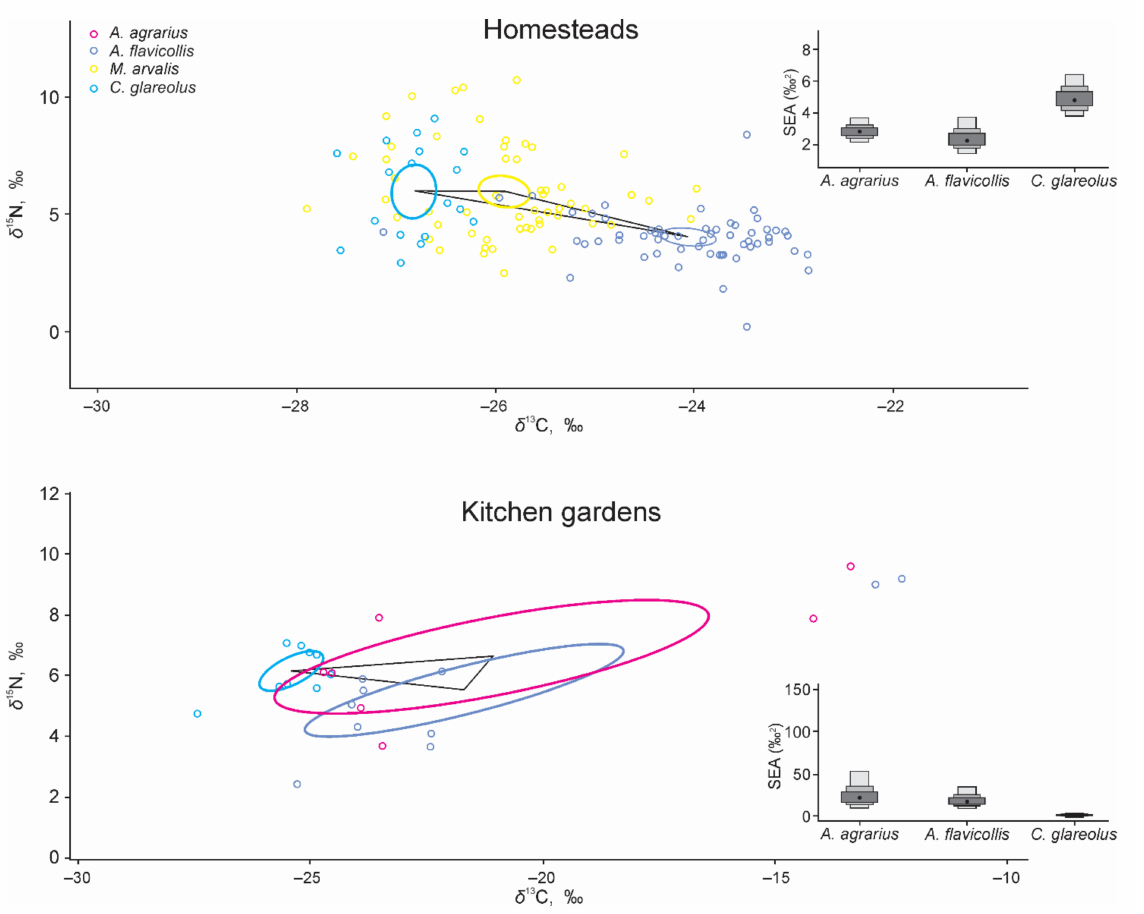
Figure 3. Central ellipses of small mammal species in isotopic space, representing fundamental niches in the homestead and kitchen garden habitats. Statistics of the total areas of isotopic spaces for these species is shown as insets for both habitats, dots representing their mode and the shaded boxes representing the 50%, 75% and 95% CI, shown from dark to light